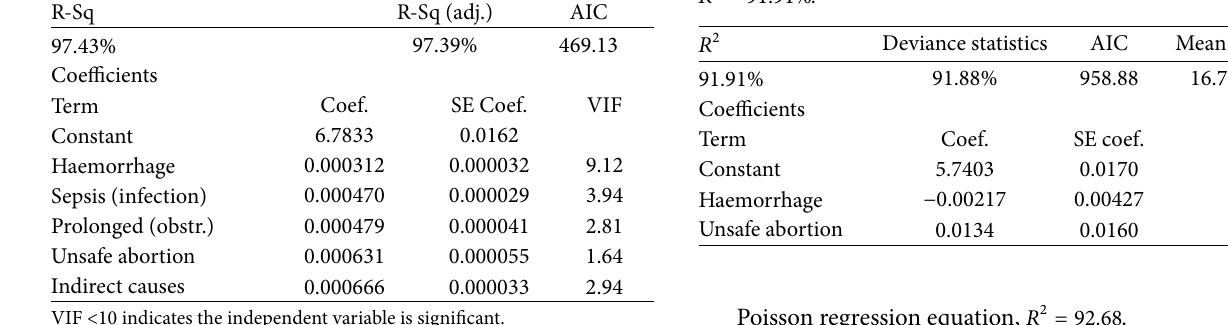
Poisson regression equation, 푅 2 = 92.68 .